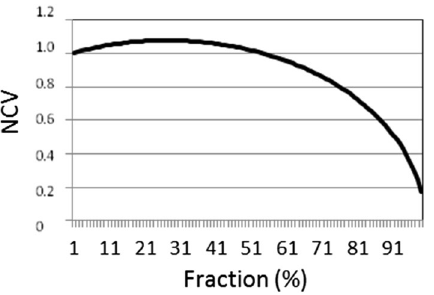
Fig. 4 Plot of RAV from the Cozzolino formula (“Appendix 1”, Eq. 8) versus gains for the case p = 50%, C = 1, RT =